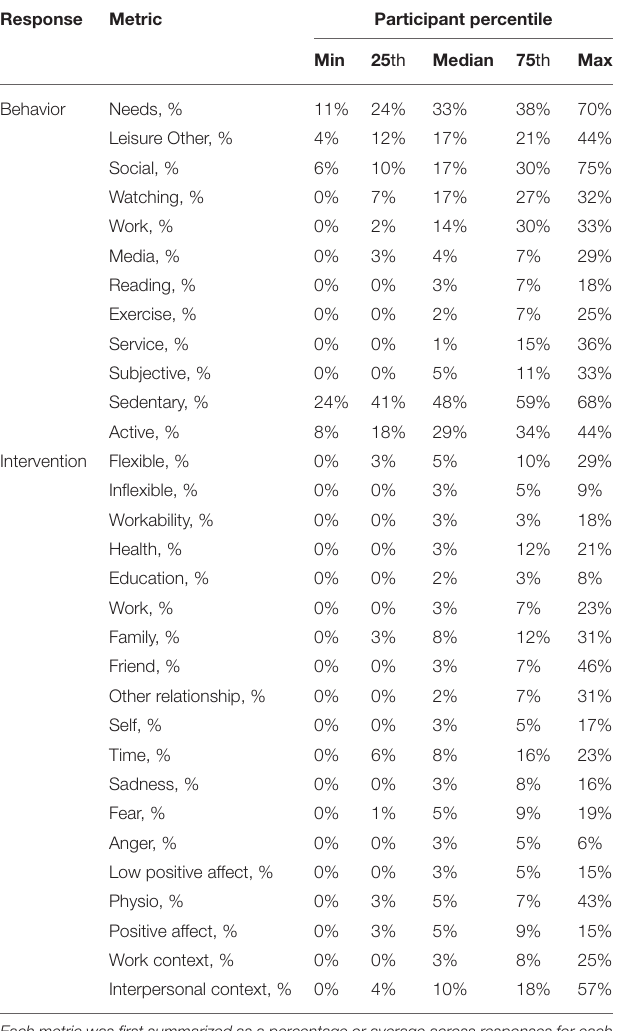
TABLE 5 | Distribution of percent responses with a given code across participants in BP cohort. Response